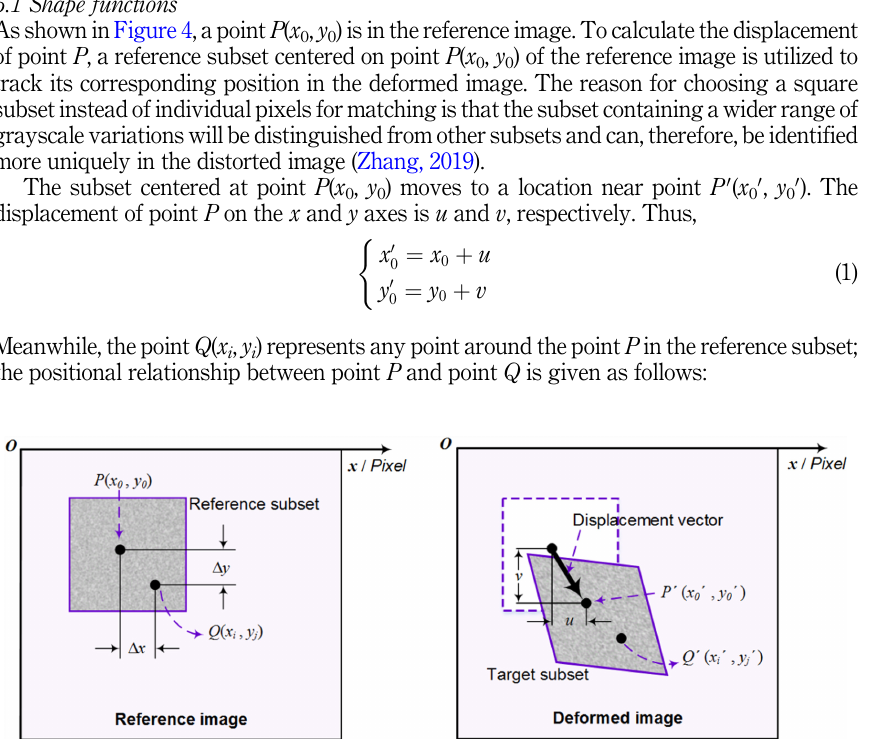
Figure 4. Schematically illustration of a reference square subset before deformation and a targeted subset after